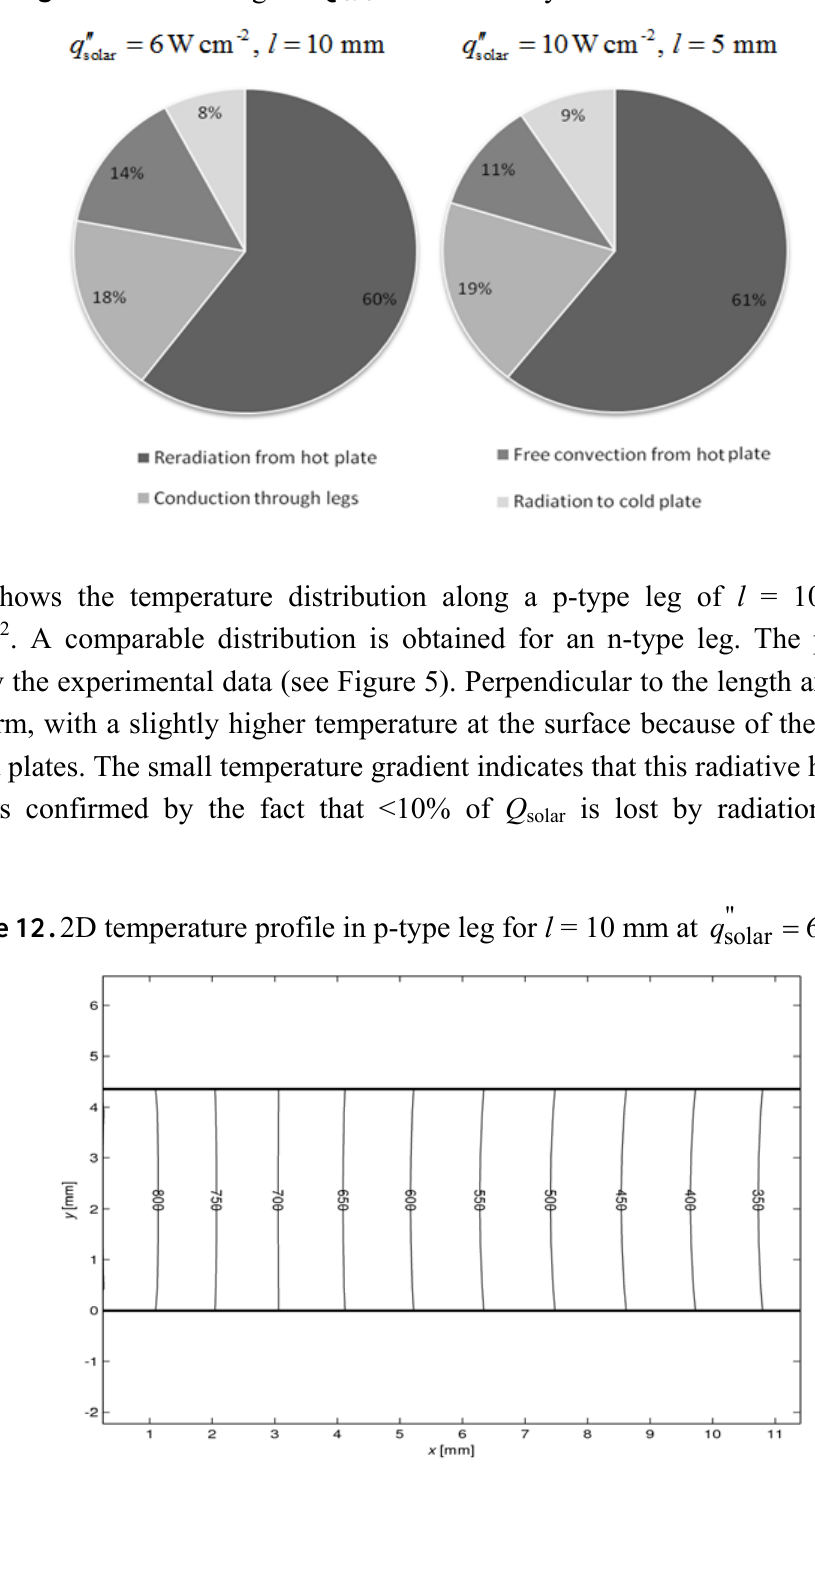
Figure 11. Percentage of Q